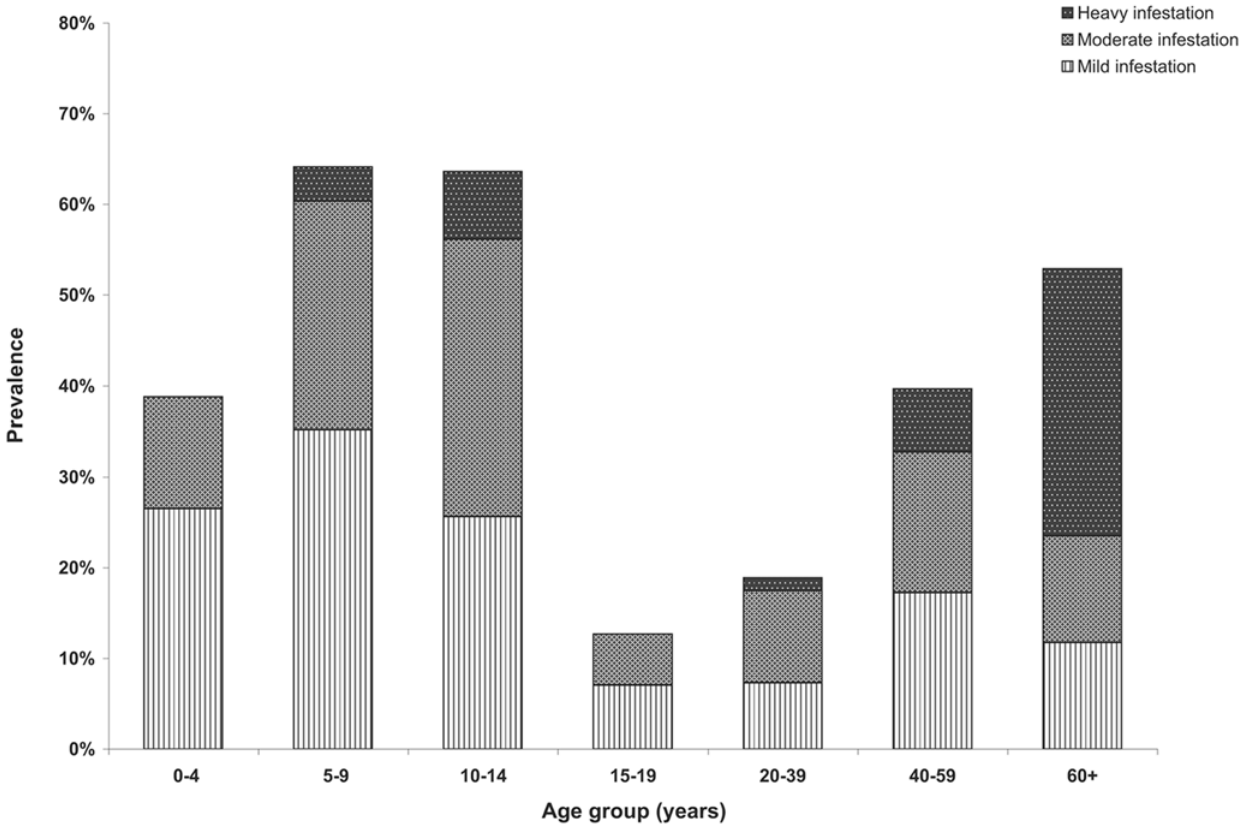
Figure 1. Prevalence of tungiasis stratified by age group and severity of infestation.